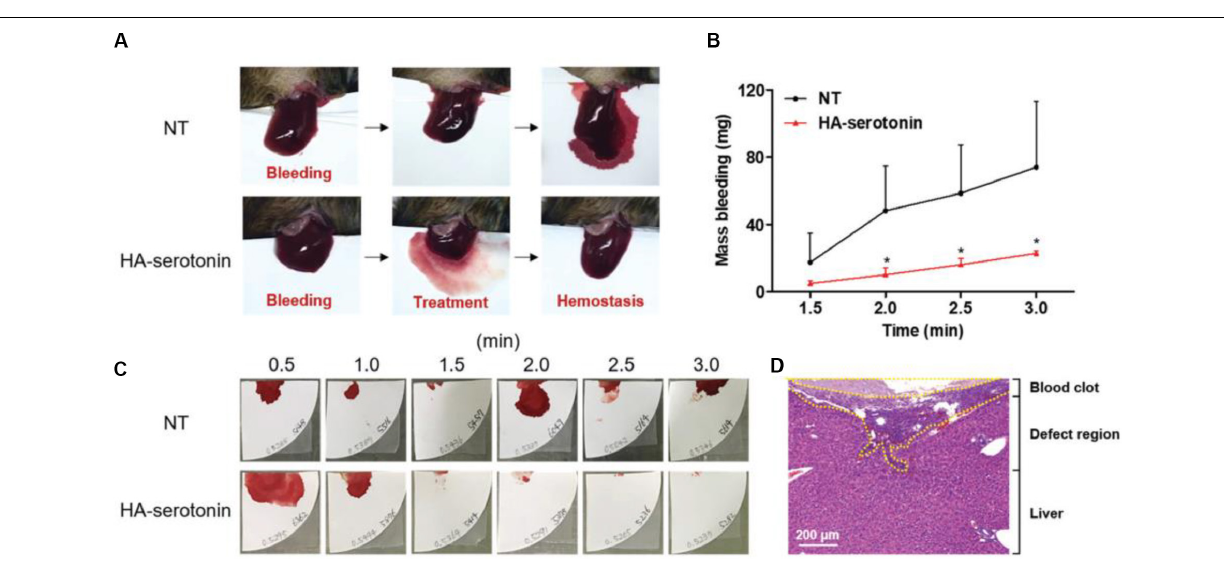
FIGURE 10 | (A) HA-serotonin-mediated hemostasis in a liver hemorrhage model of Factor VIII-deficient hemophilia mice without treatment (NT, top) and treatment by hemostatic adhesives (HA-serotonin, bottom). (B) Accumulated blood loss from hemophilia mice after bleeding without any treatment (NT, black) and treatment of hemostatic adhesives (HA-serotonin, red) ( n = 3, * p < 0.05 versus NT group). (C) Photographs of the blood absorbed papers from non- and HA-serotonin-treated hemophilia mice every 30 s up to 3 min. (D) H&E staining of damaged liver harvested from HA-serotonin-treated hemophilia mice for 3 days. Scale bar = 200 mm. Reproduced from An et al. (2019) with permission from Copyright 2019 Royal Society of